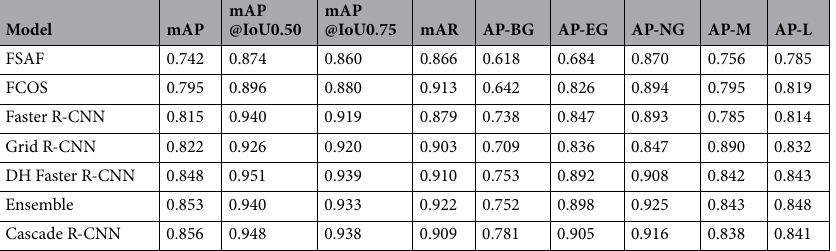
Table 2. Performance in key evaluation criteria of six methods and ensemble model on the test